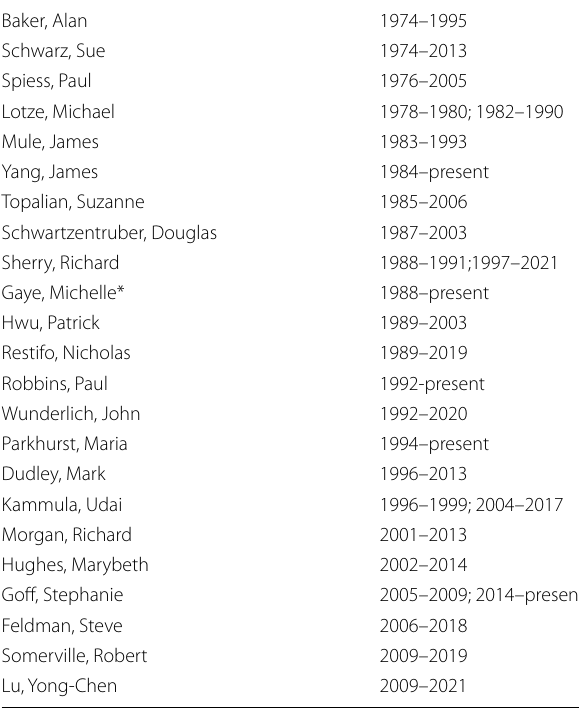
Table 1 Scientists who worked in the Rosenberg laboratory for over 10